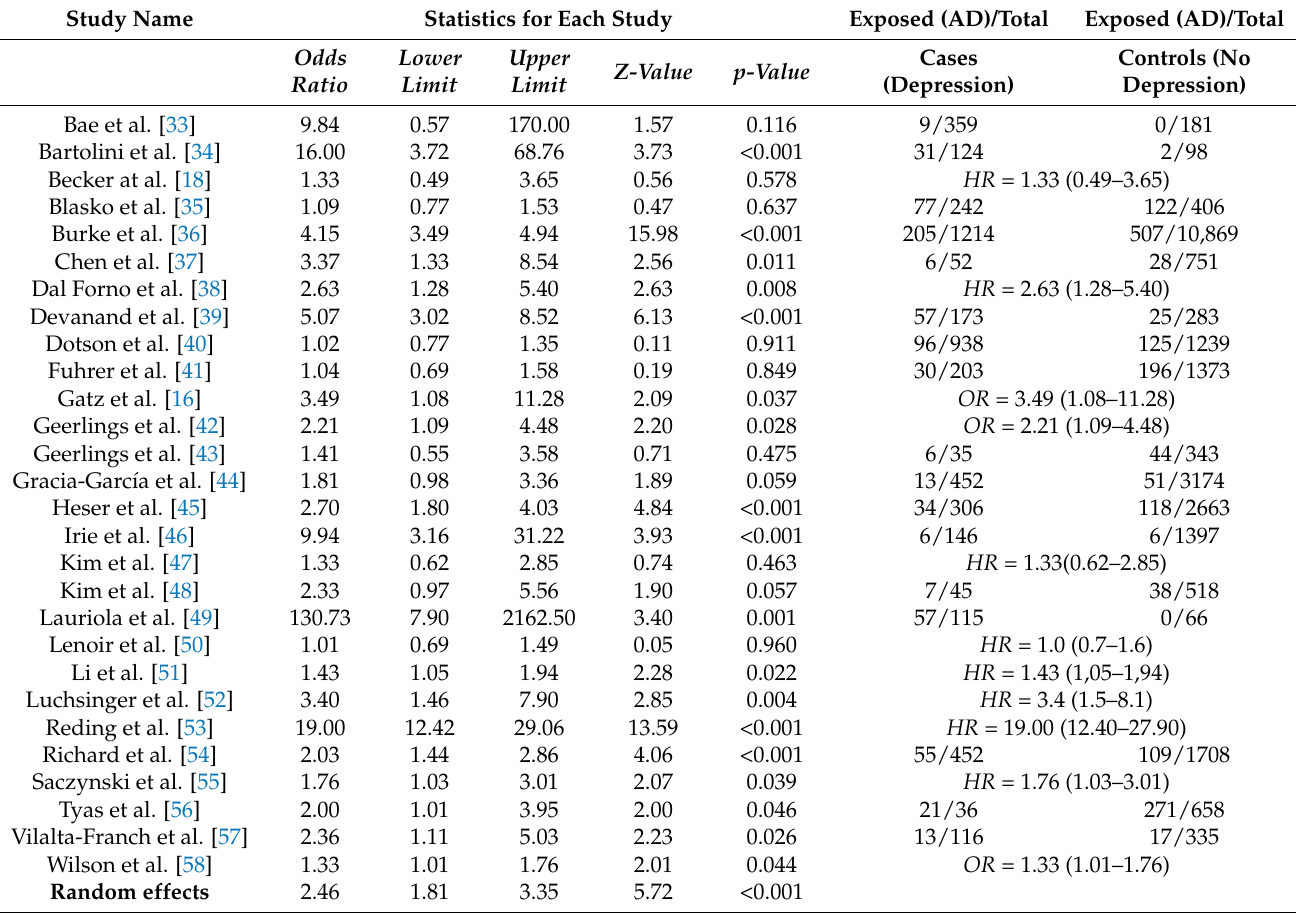
Table 2. Summary details for individual studies that examined the risk of dementia (OR) associated with